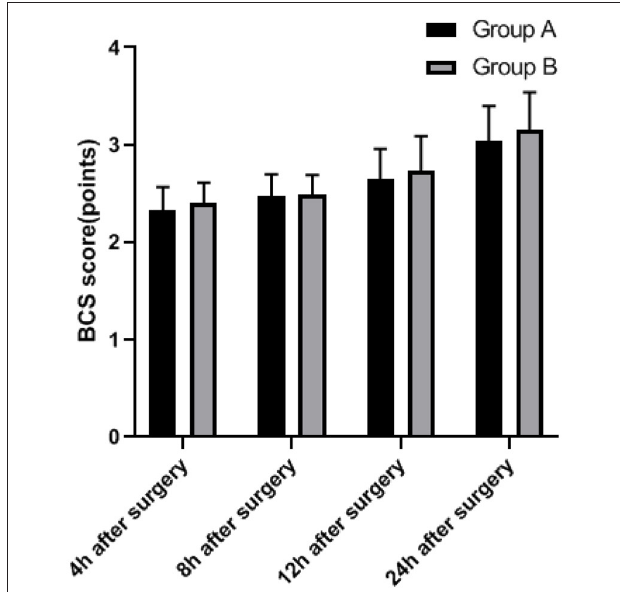
FIGURE 3 | Comparison of comfort between two groups.